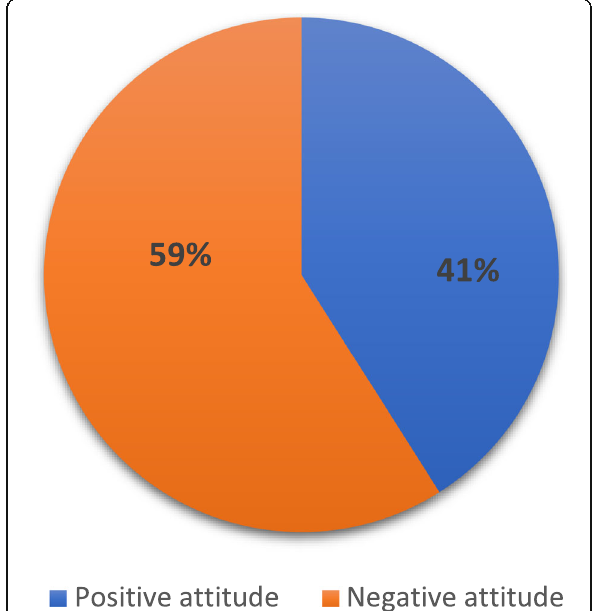
Fig. 3 Distribution of college students according to the attitude levels toward emergency contraception ( n =